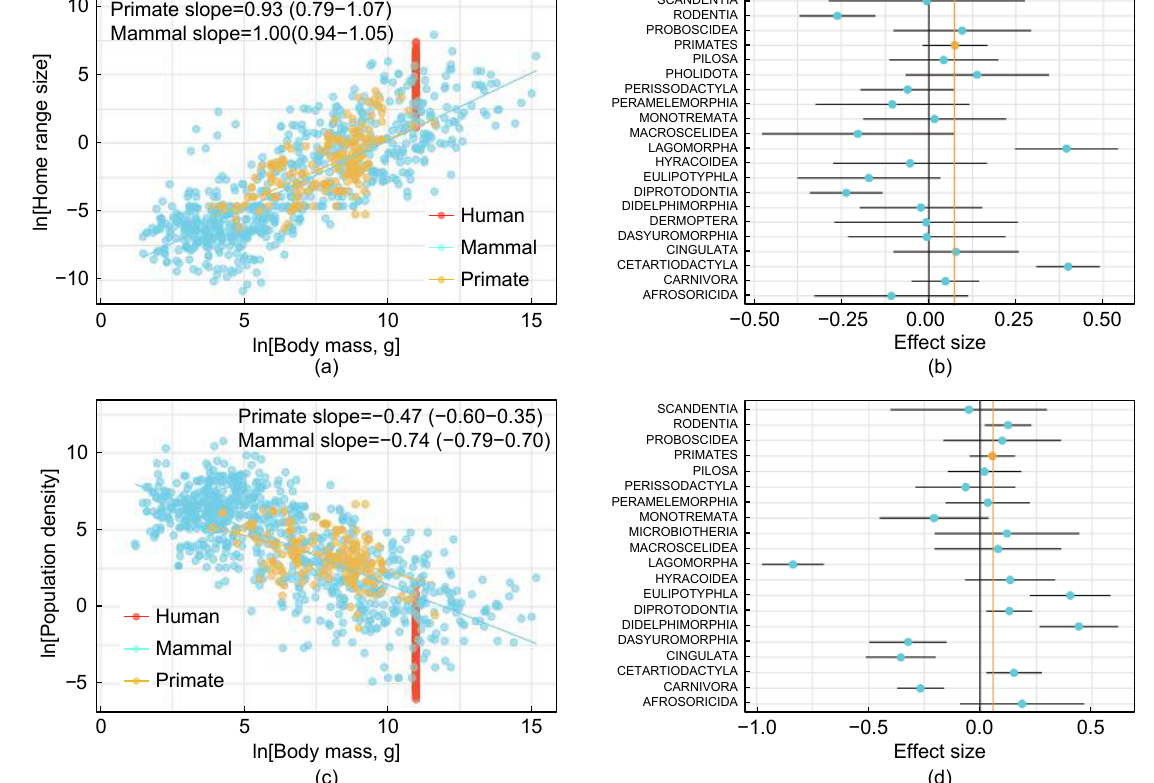
Fig. 2 Allometric scaling of home range and population density in humans (red), primates (orange), and mammals (blue). In the panels on the left, the fitted functions are OLS regressions and the slope parameters given in the panels. The panels on the right are the effect sizes for each mammal order from a mixed linear model of the data used to generate the figure on the left. The vertical line is a zero effect and the orange vertical line is the primate effect size. (a) Home ranges increase approximately linearly with body mass in both primates and mammals (see Table 3 for details in the following). Hunter-gatherers have large home ranges for their body mass. (b) The primate effect size is similar to other mammal orders. (c) Primate population densities decrease with body mass more shallowly than other mammals, but hunter-gatherers have especially low population densities for both mammals and primates. (d) The primate effect size is similar to other mammal